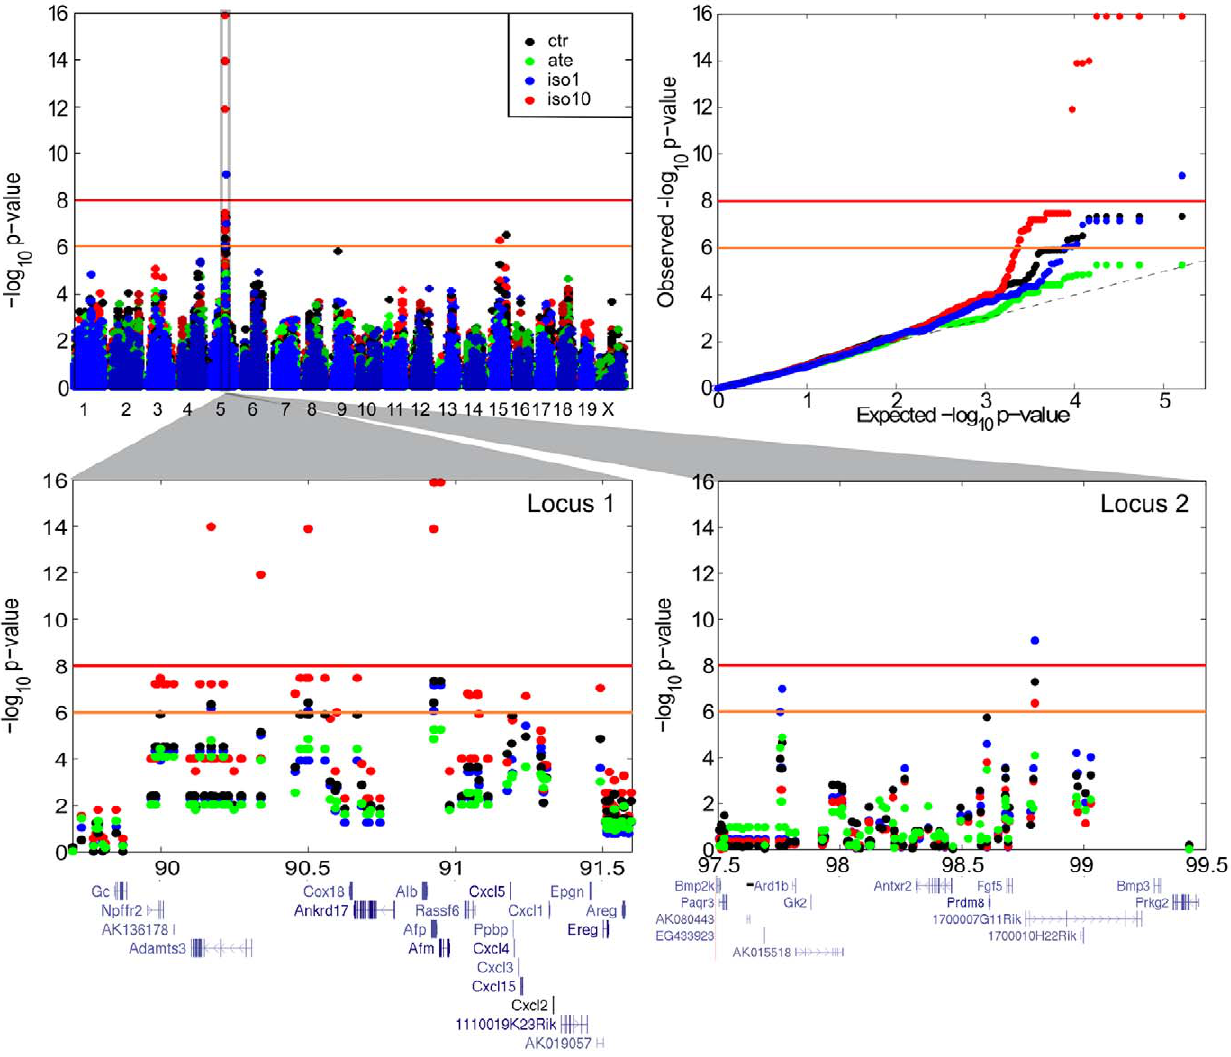
Figure 2. GWAS of non-adjusted AW. A. Composite Manhattan plot superimposing the four EMMA scans for non-adjusted AW. Association scores (-log 10 p -value; y-axis) are shown for each chromosomal position (x-axis) tested by EMMA. Suggestive and significant thresholds of association are indicated by orange and red lines, respectively. B. QQ-plots reporting the -log 10 of p -values as obtained by EMMA. The null hypothesis ( H 0 ) is indicated by the dotted line. A strong upper deviation from this line in the region of the lowest p -values is indicative of a true association. C, D. Zoom- in on loci 1 and 2. Genes are displayed as indicated in the NCBI37/mm9 assembly of the UCSC genome browser [86].